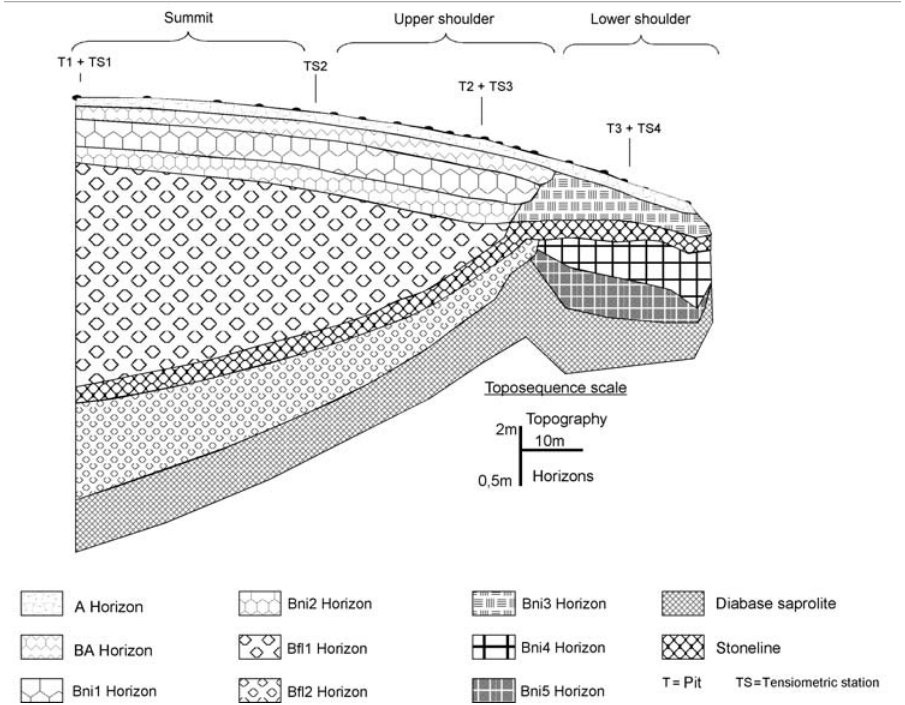
Figure 1. Soil distribution on the toposequence (Bni: nitic horizon; Bfl: ferralic horizon). Table 3. Field morphology